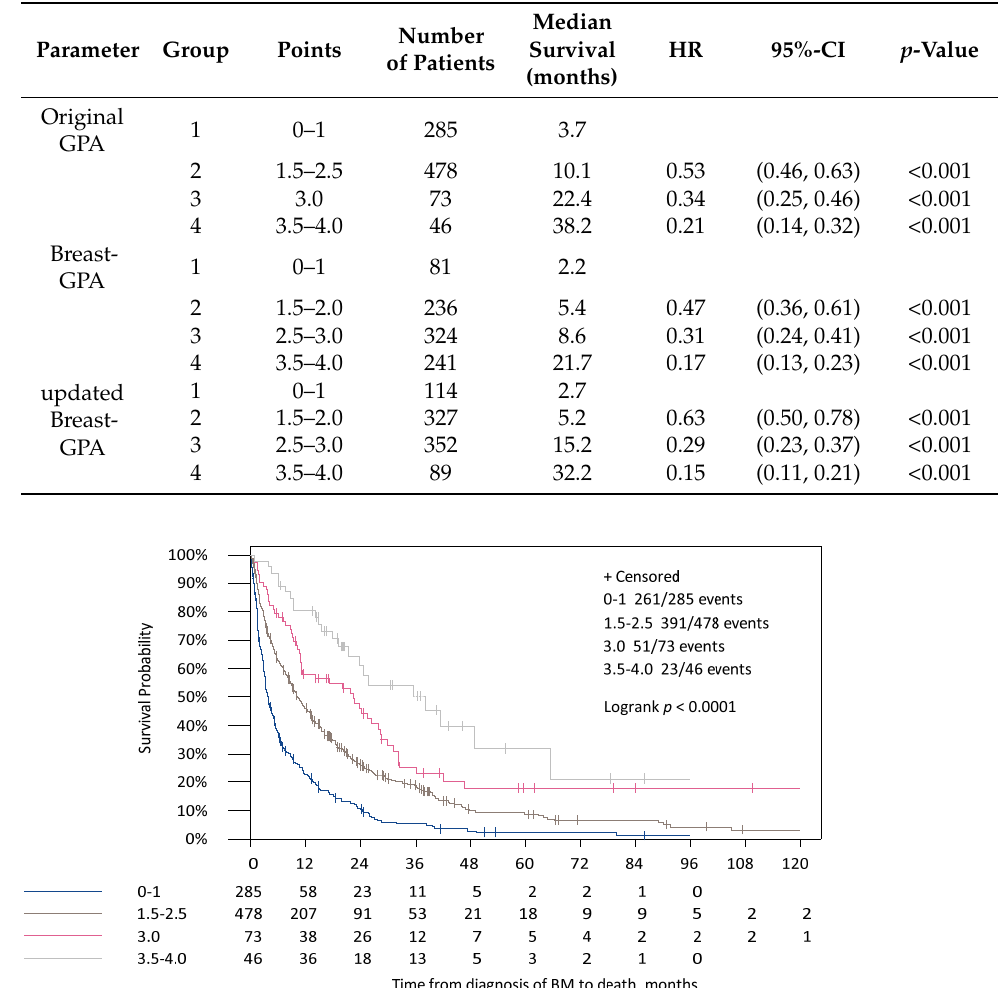
Table 4. Median survival according to the three GPA scores after the diagnosis of BM.